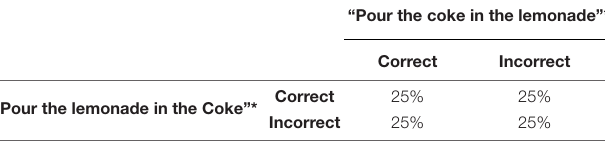
TABLE 2 | Likelihoods of different combinations of random chance responses for pairs of sentences.